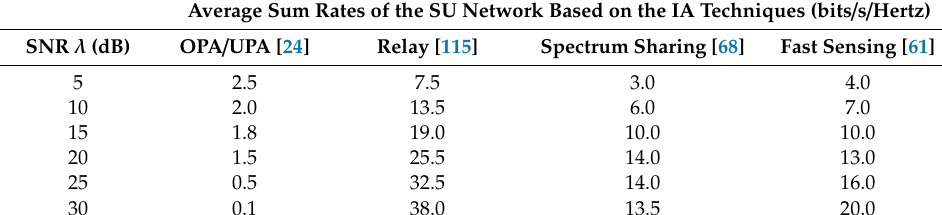
Table 5. Average sum rates against typical SNR values for the second paradigm with spatial water filling (SWF) for the single SU MIMO link [24,61,68,115].